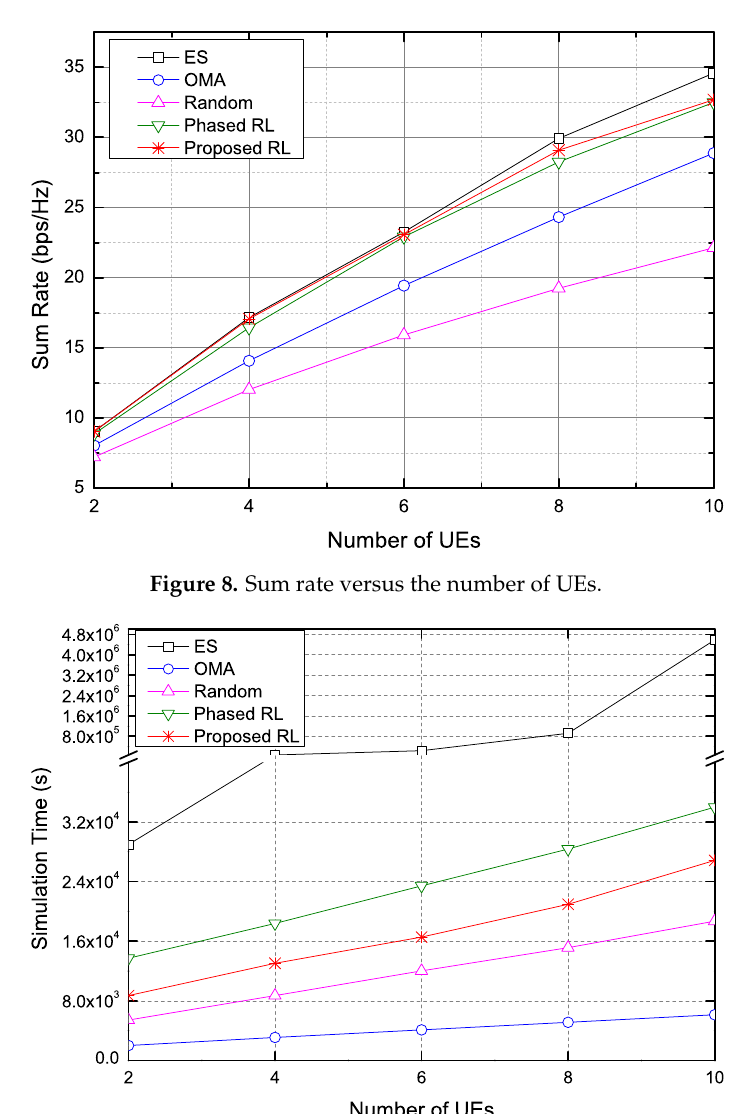
Figure 9. The total simulation time for 1000 iterations versus the number of